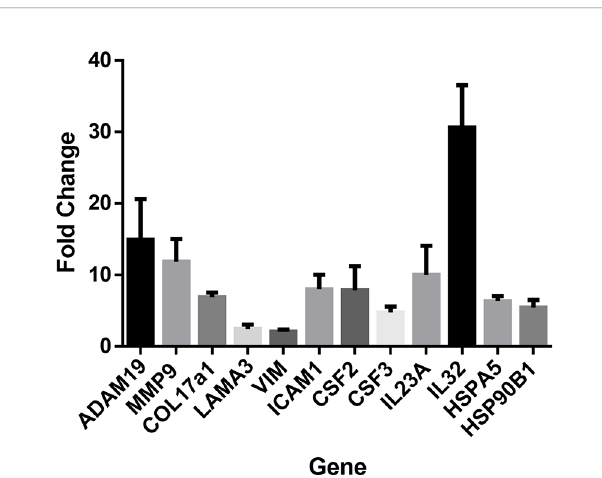
FIGURE 2 | RT-PCR was performed to con fi rm next generation sequencing fi ndings in several gene classes including cytokines, chemokines, heat shock proteins, proteases, and structural proteins. RT-PCR was performed in duplicates of laminin (n=4) or control cultures (n=3). Upregulation of ADAM19, MMP9, COL17A1, LAMA3, VIM, ICAM1, CSF2, CSF3, IL23A, IL32, HSPA5, and HSP90B1. Values indicate fold-change of laminin treated